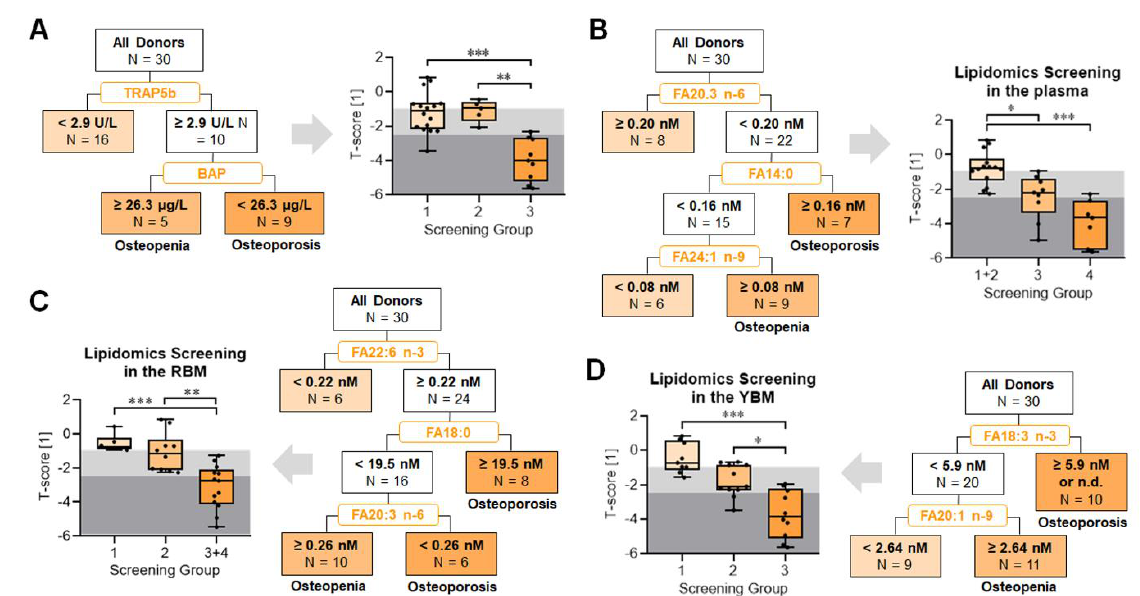
Figure 6: Potential screening strategies for reduced bone mineral density were identified using partition analysis. ( A ) Screening for reduced age adjusted bone mineral density (T-score) based on the bone markers detected in the plasma. Screening for reduced T-scores based on the fatty acid composition in ( B ) the plasma, ( C ) the red bone marrow (RBM), and ( D ) the yellow bone marrow (YBM). Screening strategies are presented as flow diagrams. Screened datasets are presented as box plots with individual data points. Groups were compared with non-parametric Kruskal-Wallis test, followed by Dunn’s multiple comparison test. * p < 0.05, ** p < 0.01, and *** p < 0.001 as